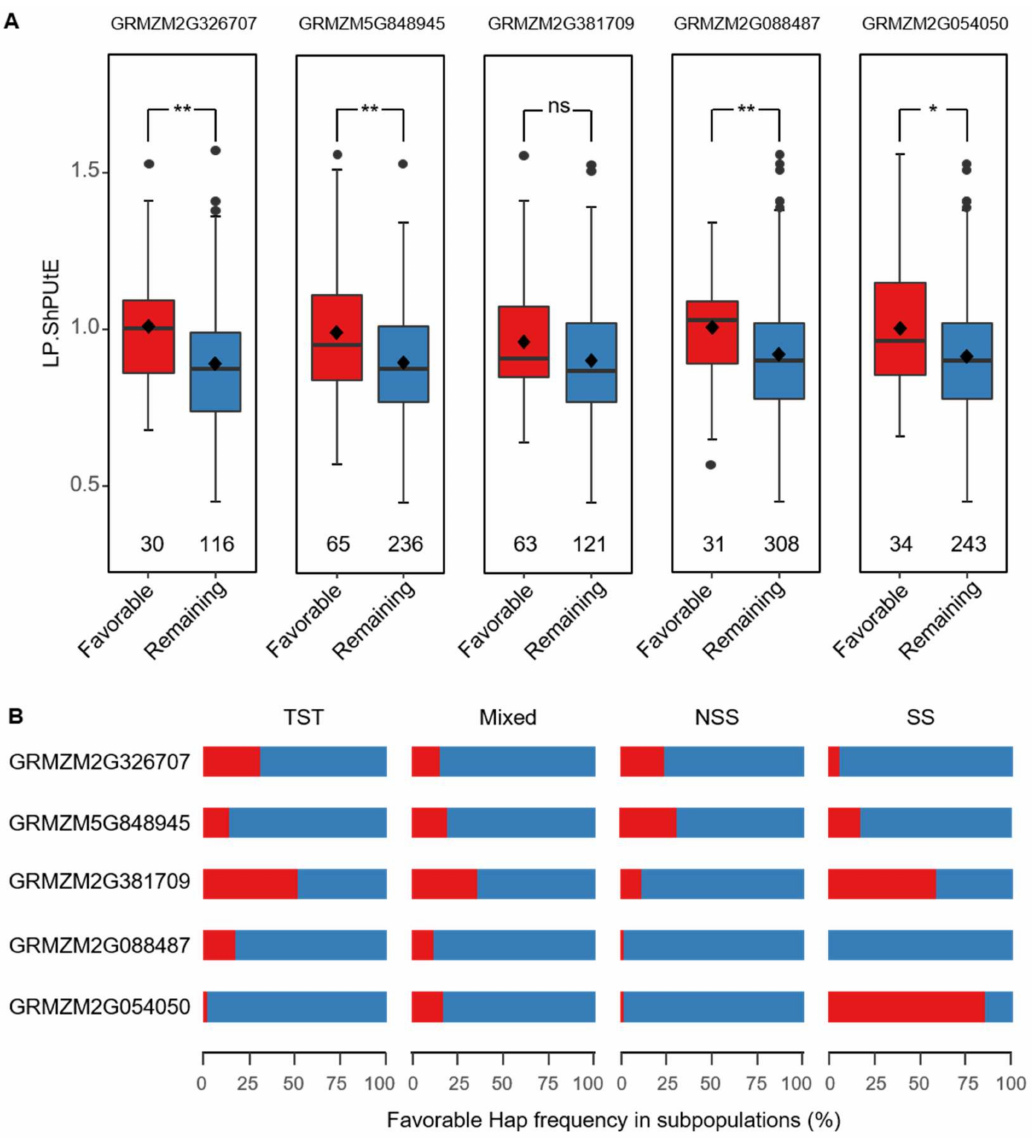
Figure 7. ShPUtE variation under low-P condition and frequencies of the favorable haplotypes of five important low-P responsive genes. ( A ) Box plots for ShPUtE under low-P condition of favorable and remaining haplotypes. The numbers in the box plot represent the individual number. The significance test was done by t -test. *: Significant at 0.05 level; **: Significant at 0.01 level; ns: No significant difference. ( B ) The proportion of two types of haplotypes in four subgroups. Red represents the favorable haplotype and blue represents the remaining haplotype. ShPUtE: Shoot P utilization